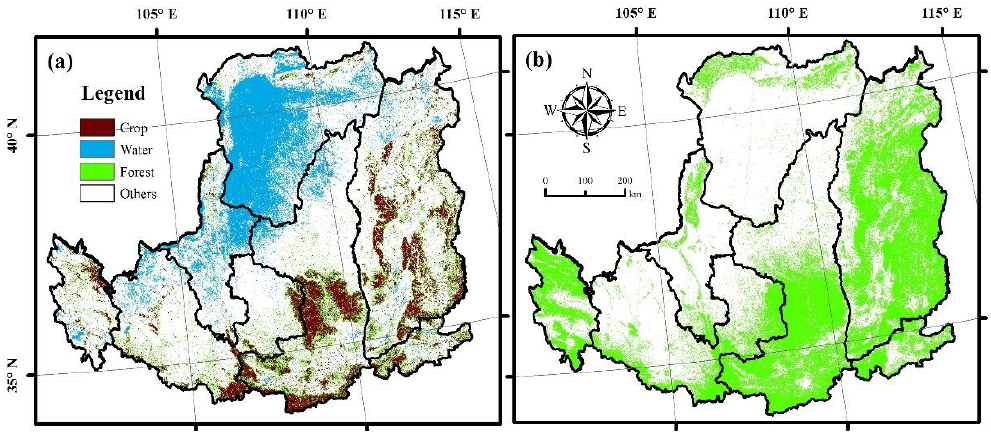
Figure 4. The PALSAR-based forest map ( a ) and the Landsat-based vegetation/non-vegetation map ( b ) in the Loess Plateau in 2010.